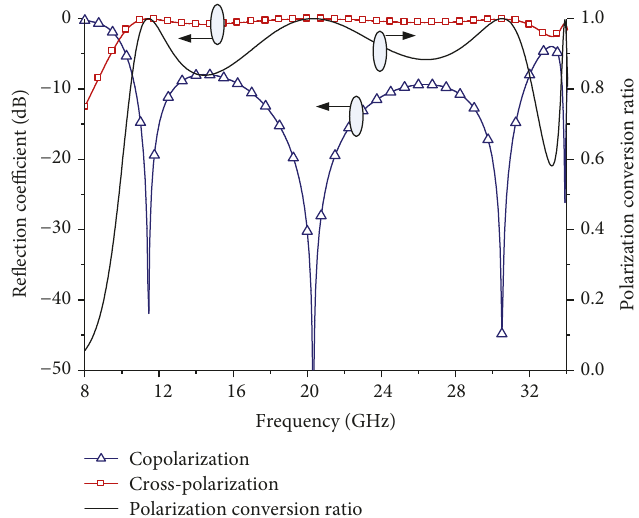
Figure 3: Re fl ection and polarization conversion performance of the PCM.